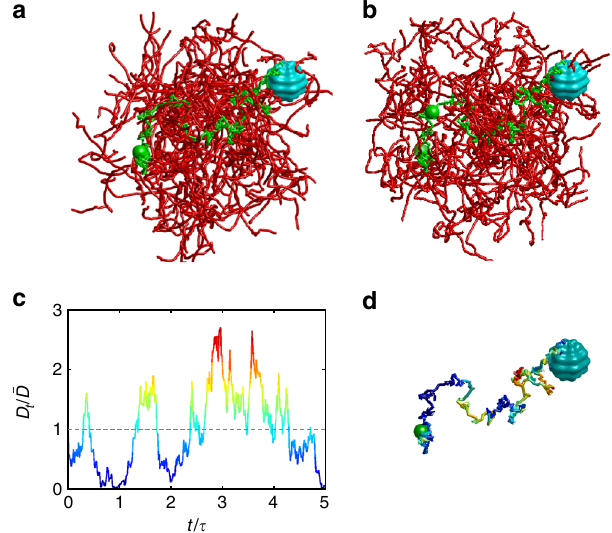
Fig. 1 Schematic illustration of the annealed disorder model. A dynamic heterogeneous medium is formed by a rearranging polymer solution (red thin tubes mimicking, e.g., actin fi laments): ( a , b ) two snapshots of a particle (small green ball) diffusing toward a reactive site (light blue bumpy object mimicking, e.g., a protein); a random path (in green) of this particle is added to guide eyes; along the path, the particle interacts with the local environment rearranging on a time scale τ and thus experiences variable effective diffusivities; ( c ) the environment-induced time-dependent diffusivity D t is modeled by the Feller process (1); ( d ) once the rearranging environment is taken into account via D t , one deals with the random path from the initial position of the particle (green ball) to the target; the path is explored with a time-dependent “ speed ” D t , encoded by color as in ( c